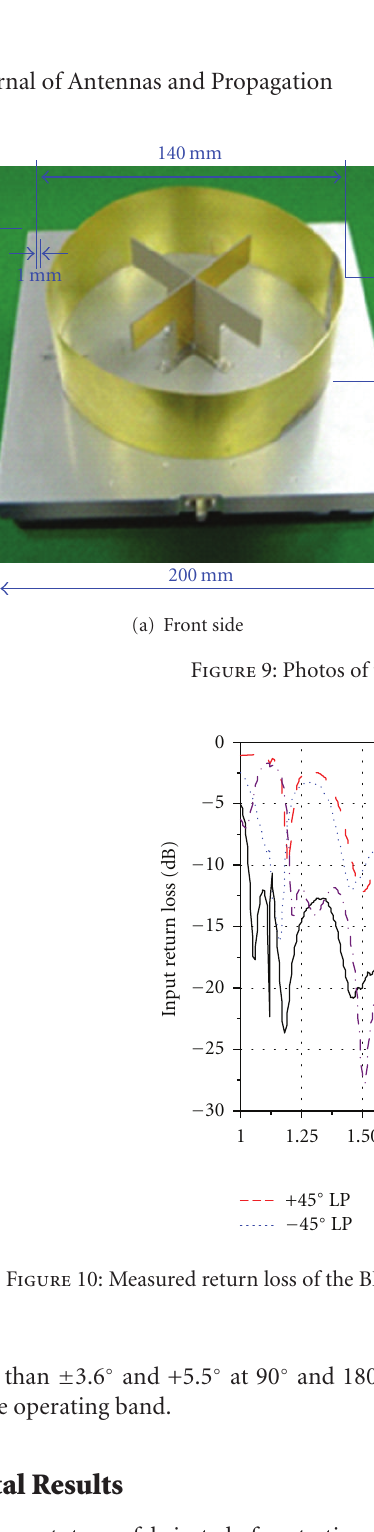
phase shift is less than ± 3.6 ◦ and +5.5 ◦ at 90 ◦ and 180 ◦ bit, respectively, in the operating